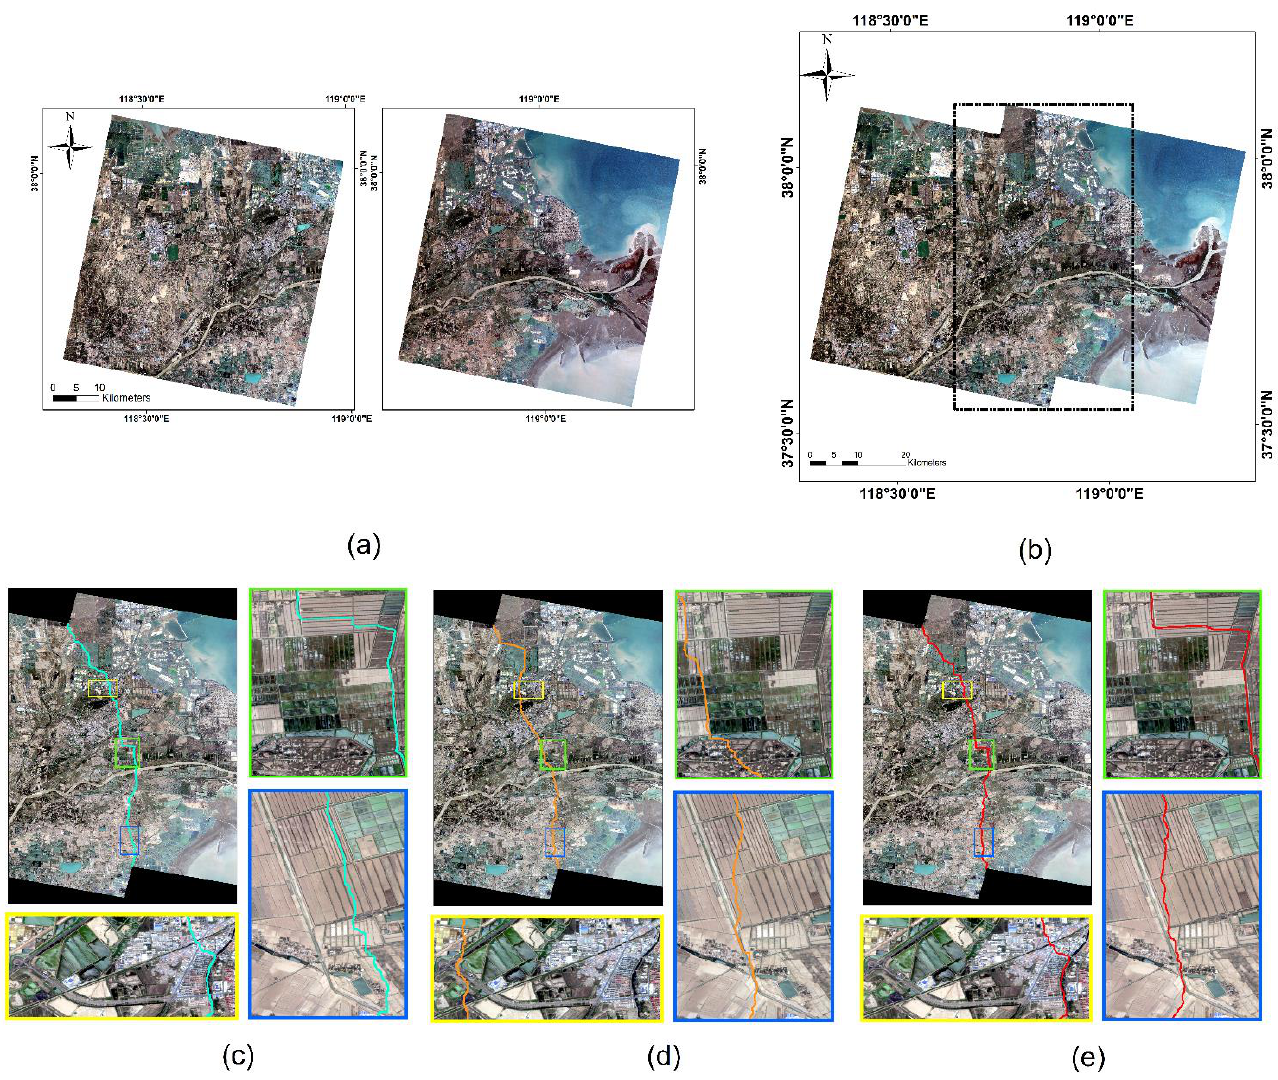
Figure 10. Comparison of the seamline on Dataset 3: ( a ) original large remote sensing images; the stitching result obtained by ( b ) our method; ( c ) Dijkstra; ( d ) Resample+ Dijkstra; and ( e ) ours. Three locations are selected to show the refinement differences of the seamlines obtained by different algorithms with rectangular boxes of different colors. The colored line in the image is the seamline.